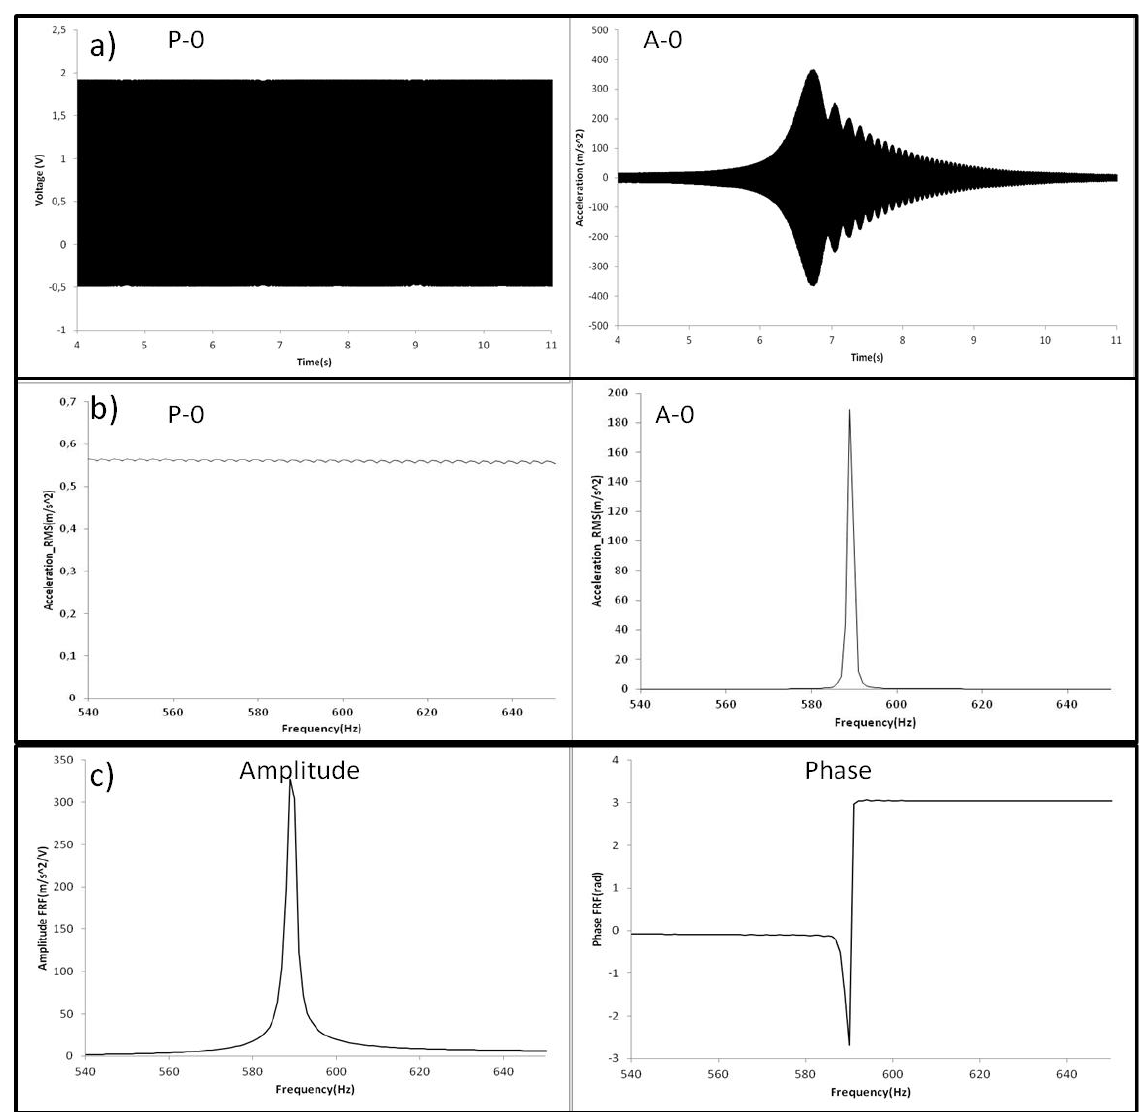
Figure 7. Determination of the natural frequencies of the rotating disk. ( a ) Time signals; ( b ) Signals after FFT; ( c ) FRF Amplitude and